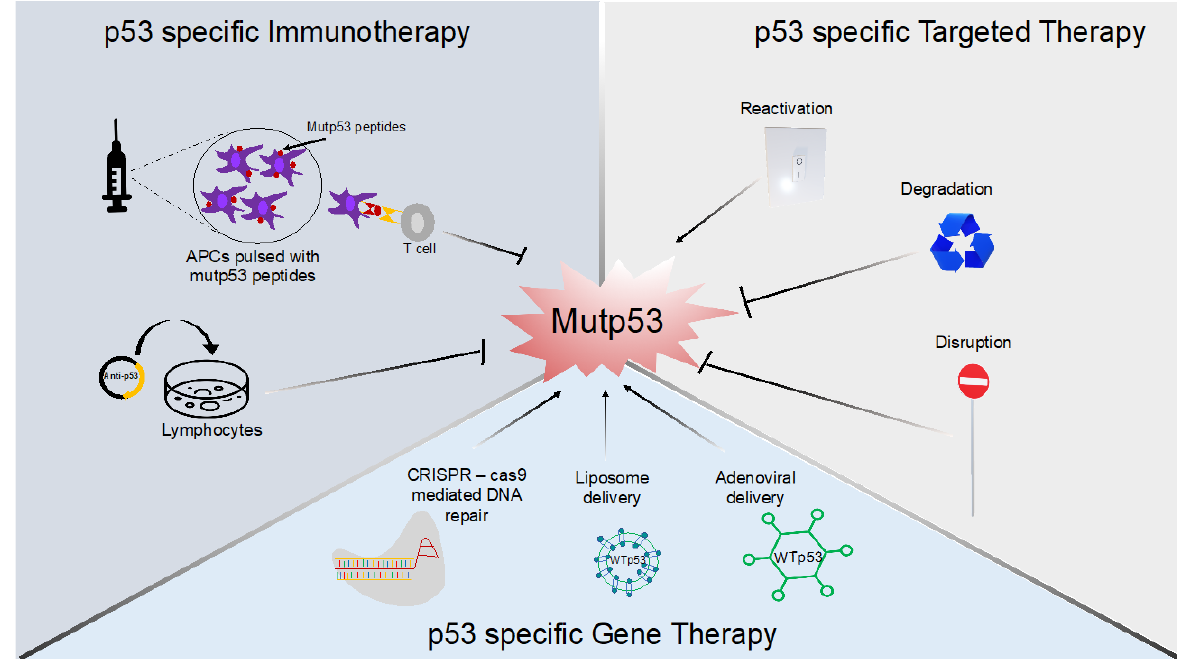
Figure 4. Mutant p53-targeting therapies. Examples of three treatment strategies specifically targeting mutant p53 using immunotherapy, targeted therapy, or gene therapy are shown.